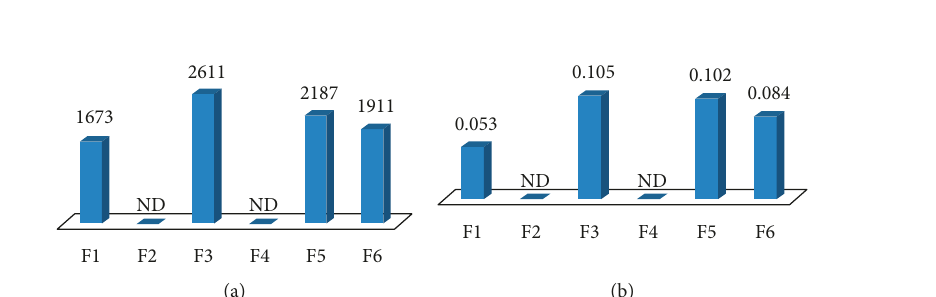
ND, not determined.